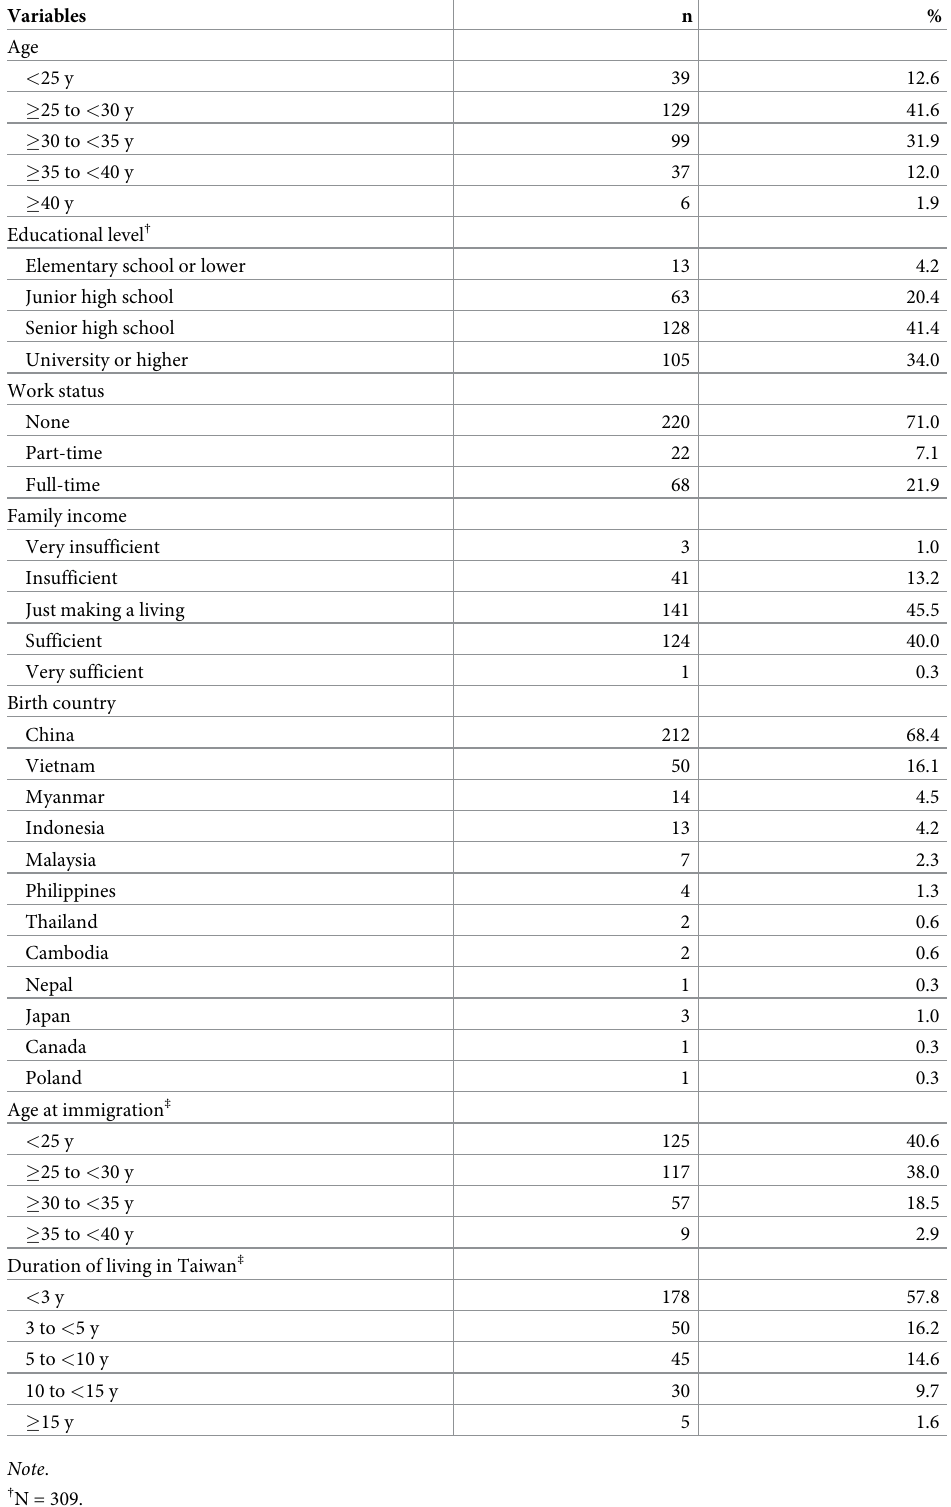
Table 2. Characteristics of the study participants (N =